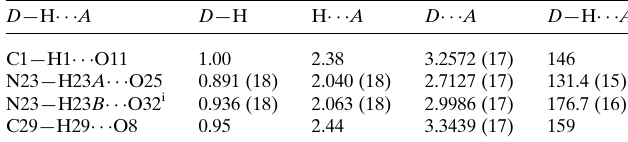
Table 1 Hydrogen-bond geometry (A˚ , (cid:2) ).